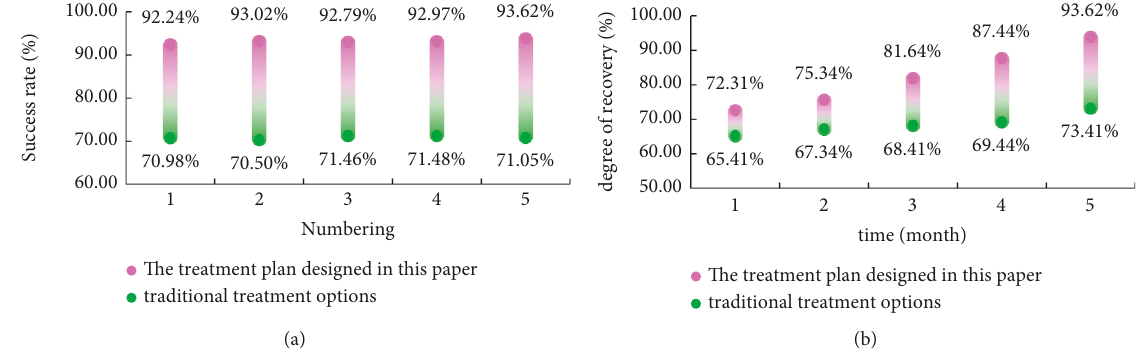
Figure 10: Comparison of results with traditional treatment regimens. (a). Surgical treatment success rate. (b). Degree of recovery after